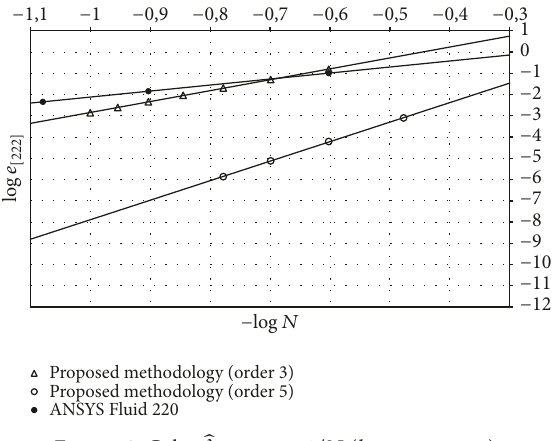
1/𝑁 ( ℎ 222 versus